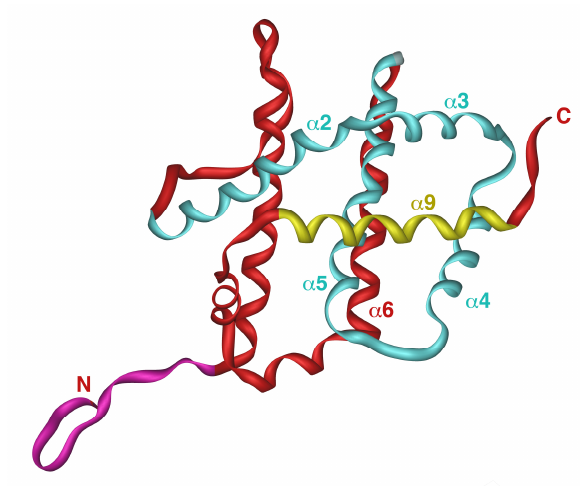
FIGURE 2: Structure of the human Bax. NMR structure of the human Bax is shown with following structural features empha- sized: N-terminal domain in purple, hydrophobic groove in blue and α-helix 9 in yellow. Picture was generated by iMol 0.40 soft- ware using structural data from